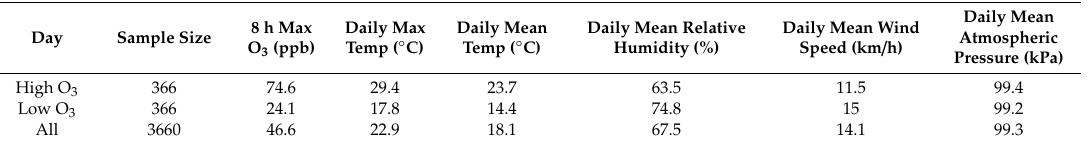
Table 4. Meteorological parameters in smog season high O 3 (>90th percentile 8 h max O 3 ), low O 3